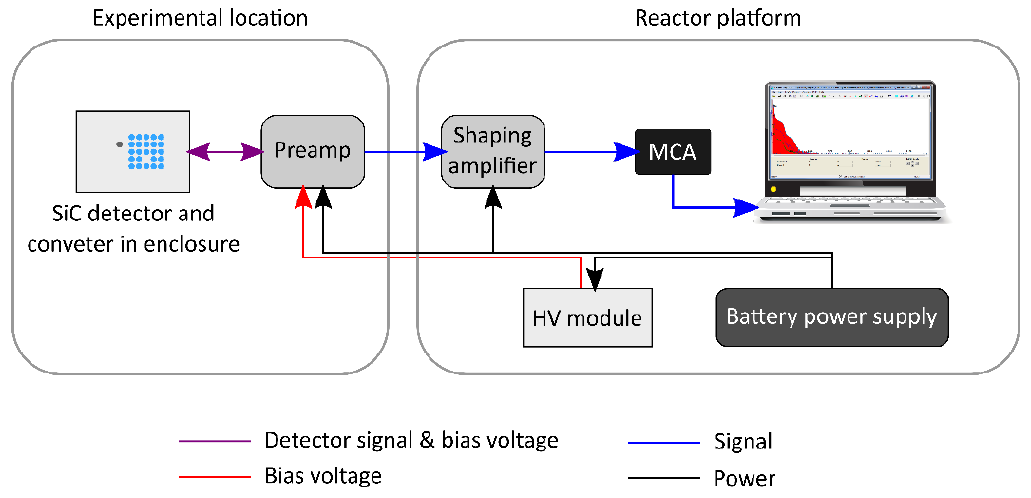
Figure 3: Schematic representation of the data acquisition